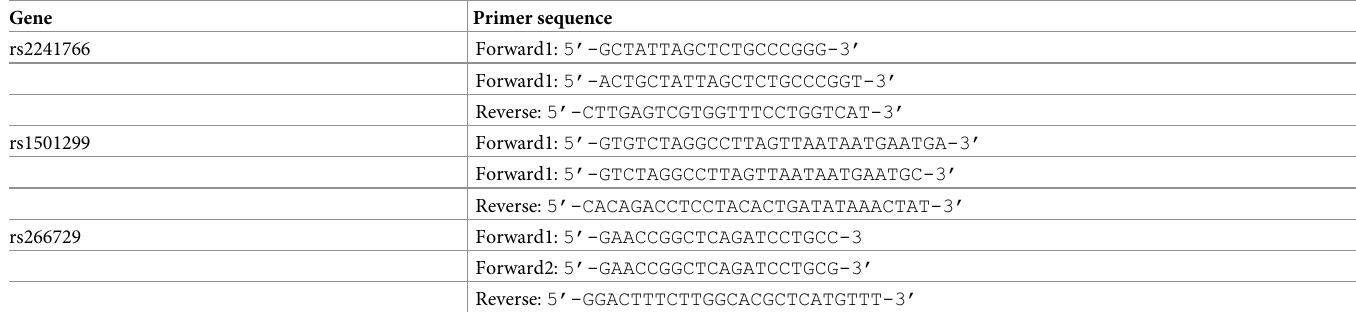
Table 1. Primer sequences for the Kompetitive Allele Specific Polymerase Chain Reaction (KASP) of rs2241766, rs1501299, and rs266729.